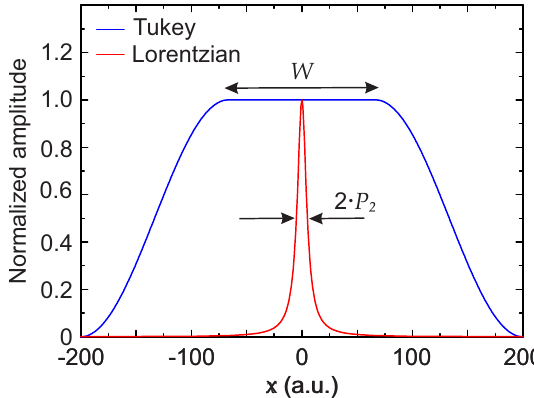
Figure 2. Schematic representation on how to choose the width of the Tukey window W compared to the Lorentzian HWHM P 2 . Here, it is W = 20 P 2